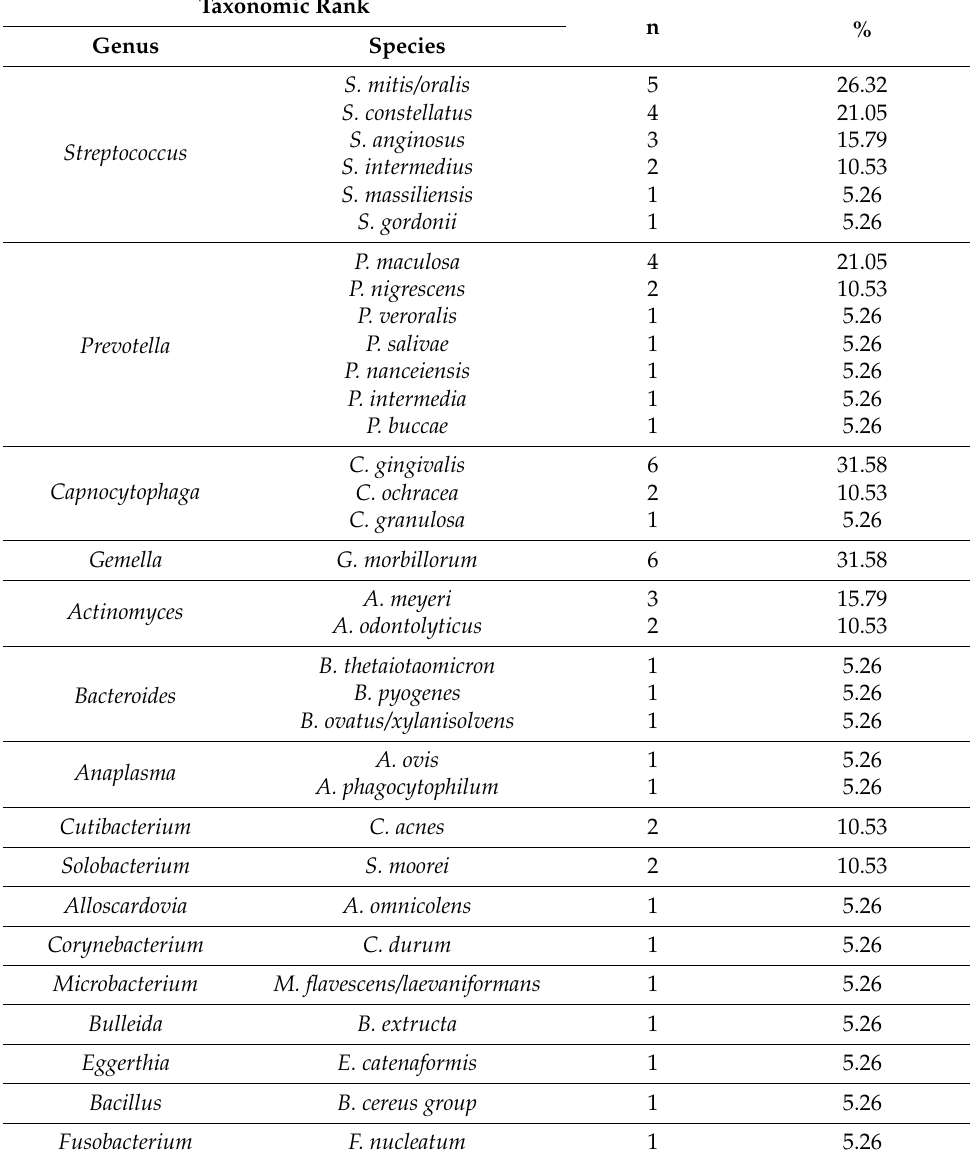
Table 4. Identification of isolated bacteria from samples.